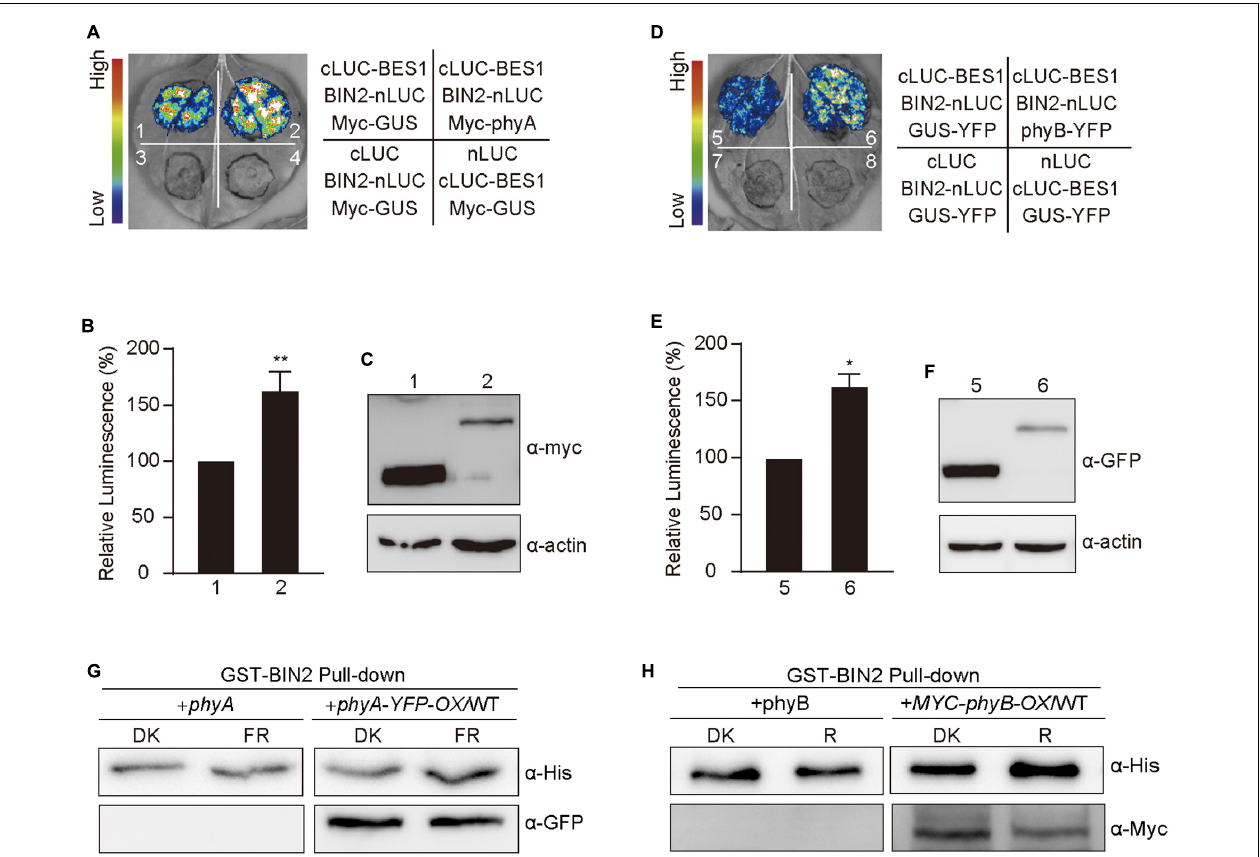
FIGURE 6 | Phytochromes A and B promote the interaction of BIN2 and BES1 proteins. (A–F) Split-luciferase complementation imaging assays indicating phyA and phyB promotion of the interactions of BIN2 with BES1 in tobacco leaves. The luminescence intensity of the samples shown in (A,D) was quantitatively analyzed, respectively (B,E) . Data are represented as the mean of biological triplicates ± SD ( n = 3). (Student’s t -test, *P < 0.05, **P < 0.01). The expression of Myc-phyA, Myc-phyB, and Myc-GUS (negative control) were detected with anti-Myc antibody (C,F) . (G,H) Cell-free GST pull-down assays showing phyA (G) and phyB (H) promotion of the interactions of BIN2 with BES1. GST-BIN2 served as bait. His-BES1 served as prey. The protein extracts prepared from the dark-adapted phyA and phyA-YFP - OX /WT or phyB and Myc-phyB - OX /WT seedlings exposed to far-red light (10 µ mol/m 2 /s) or red light (50 µ mol/m 2 /s) for 30 min,